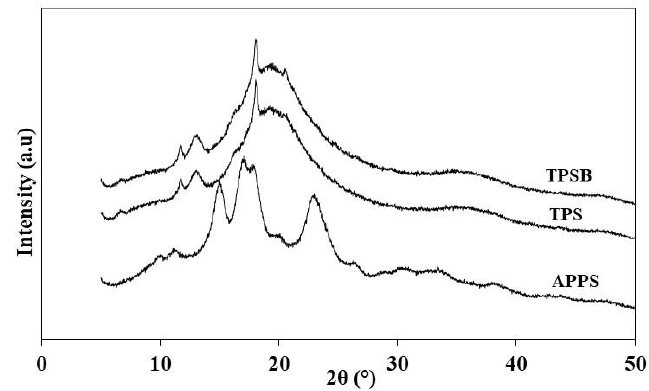
Figure 4. XRD pattern of APPS, TPS and TPSB.